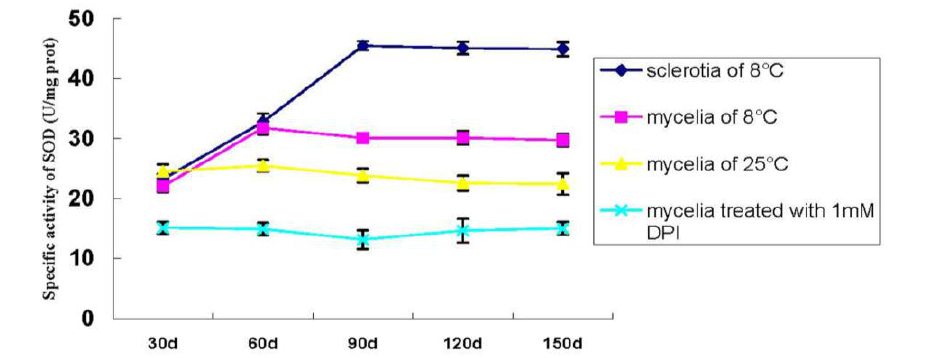
Figure 6. Specific activity of SOD during P. umbellatus sclerotial